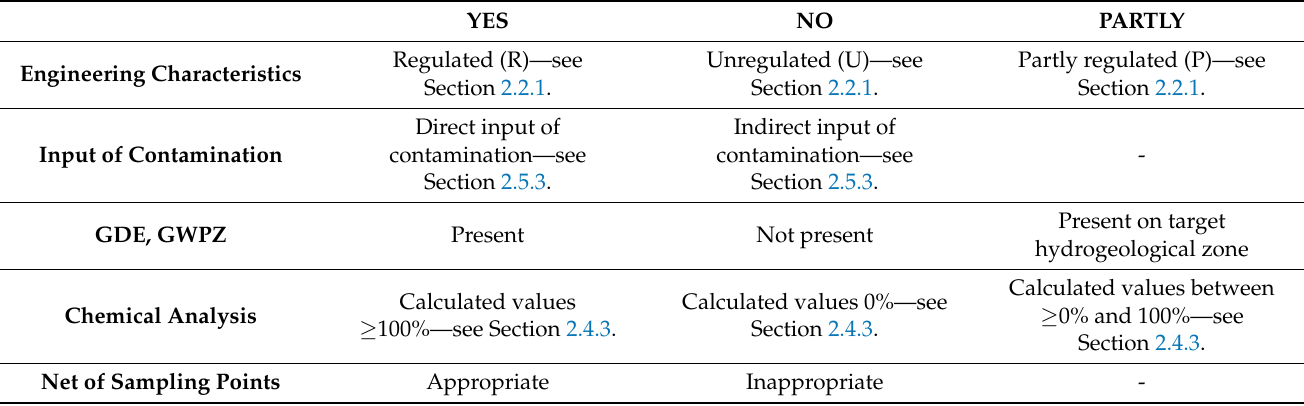
Table 3. Criteria of hydrogeological and engineering characteristics for classifying landfills into three priority